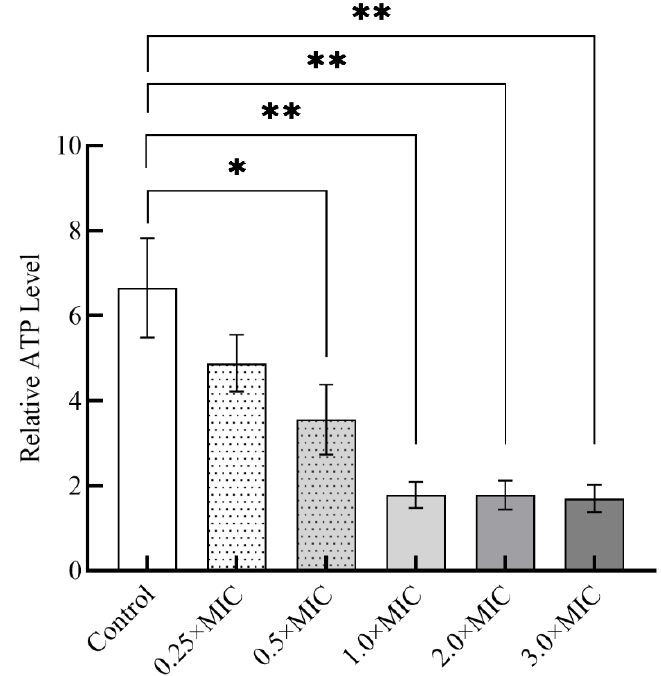
Figure 5. Effects on ATP levels in H. pylori ZJC03. ATP of H. pylori ZJC03 co-cultured with different concentrations of PLNC8 for 30 min; Control: 0.05% acetic acid buffer; Data are shown as the average ± SD; n = three groups parallel. * p < 0.05 and ** p < 0.01; there was no significant difference if it was not marked.